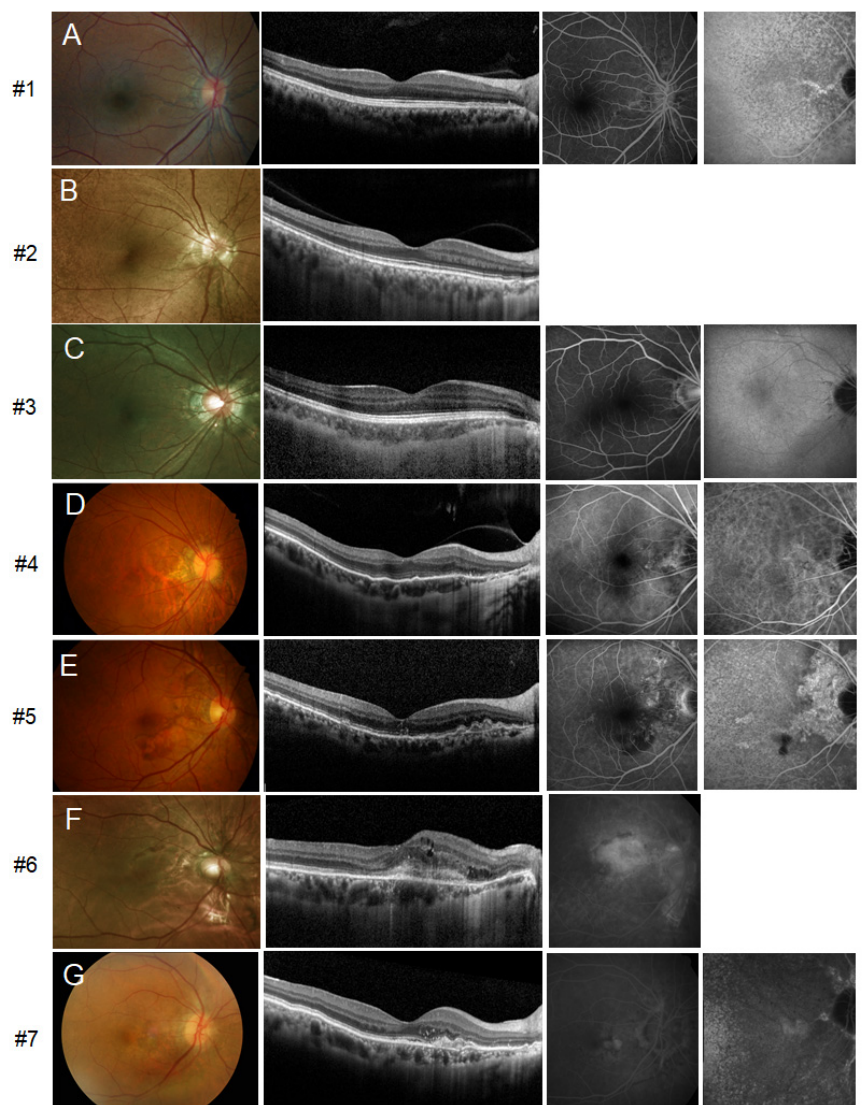
Figure 1. Multimodal imaging at the initial presentation. Images of the right eyes of patients are presented because both eyes exhibited symmetric features. From left to right, fundus photography, optical coherence tomography (OCT), fluorescein angiography (FA), and indocyanine green angiography (ICGA) are shown. ( A – D ) Fundus photographs of asymptomatic patients showing AS radiating from the optic disc. The horizontal OCT scan shows peripapillary disruption of the Bruch’s membrane-RPE complex and undulation of the overlying photoreceptor layers. AS was identified as hyperfluorescent lines without leakage on FA. Late-phase ICGA images showed a central zone of decreased fluorescence at the posterior pole, and AS showed an increased fluorescence signal within the central area of hypofluorescence. ( E – G ) Fundoscopy of right eye of patient #5 shows submacular hemorrhage and corresponding OCT reveals fibrovascular pigment epithelial detachment along with breakage of Bruch’s membrane. However, choroidal neovascularization (CNV) was not definitively identified with FA and ICGA, and the occurrence of spontaneous submacular hemorrhage due to Bruch’s membrane break is suspected ( E ). #6 had subfoveal CNV in the right eye, which was confirmed with FA ( F ). The initial presentation of #7 shows nasal parafoveal subretinal CNV in the right eye ( G ).